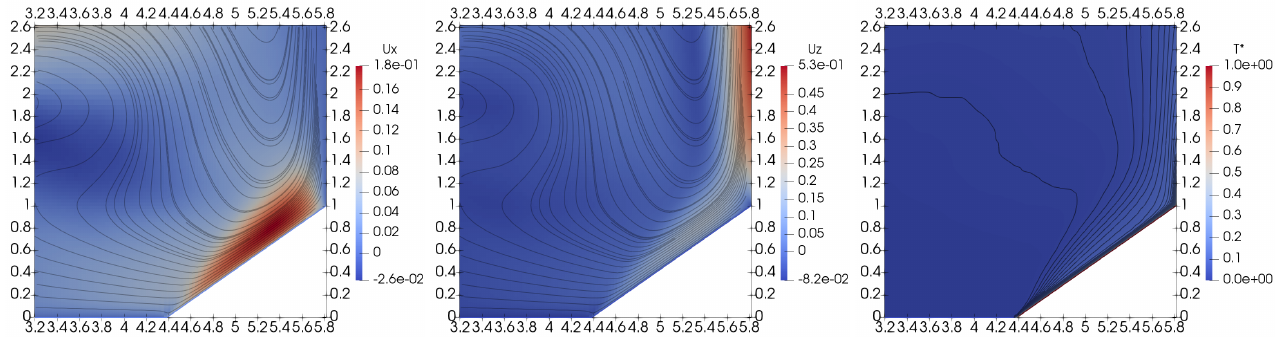
Figure 7. Spatial distribution of non-dimensional mean velocity components in horizontal U x = (cid:104) u x (cid:105) / U b and vertical U z = (cid:104) u z (cid:105) / U b directions (streamlines are superimposed), together with temperature T ∗ = (cid:104) T (cid:105) / T s (contour lines at 100 equally spaced values are reported as black solid lines). Vertical plane normal to spanwise direction, reduced to the observation